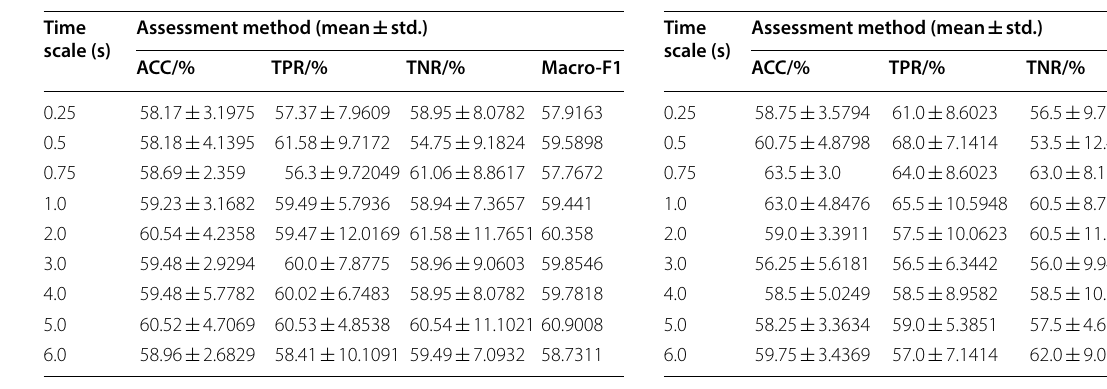
Table 4 The classification results of RT‑ERM with different time scales for γ rhythm under the dimension of emotion valence Time Assessment method (mean scale (s)